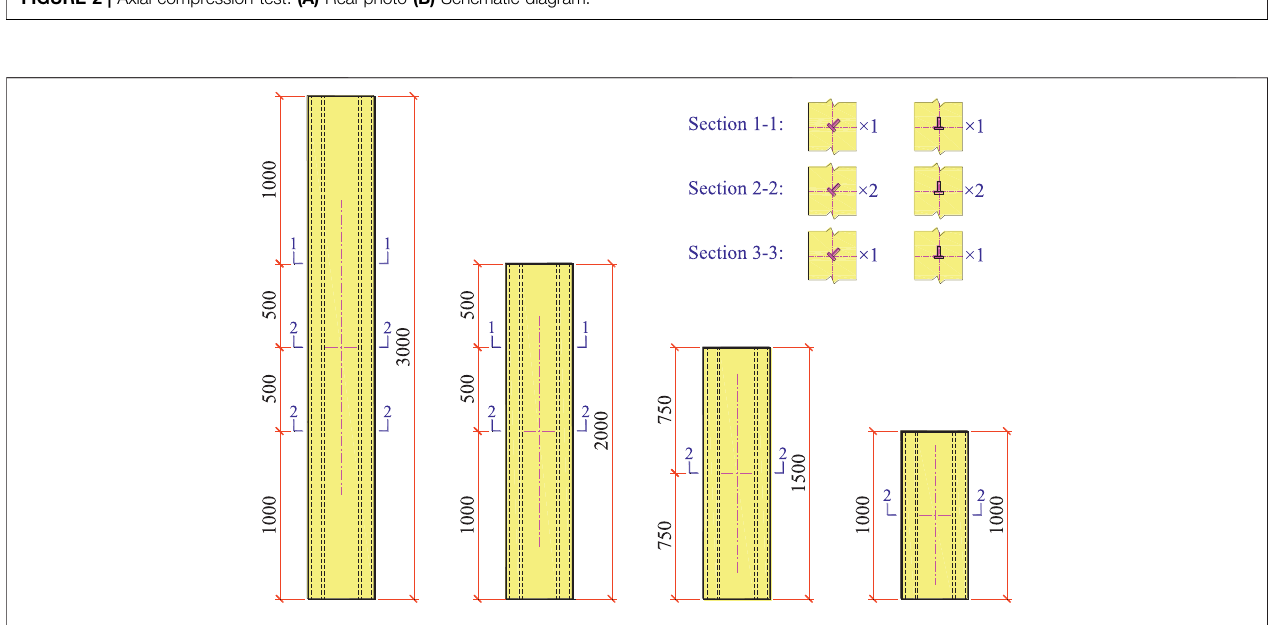
FIGURE 2 | Axial compression test. (A) Real photo (B) Schematic diagram.